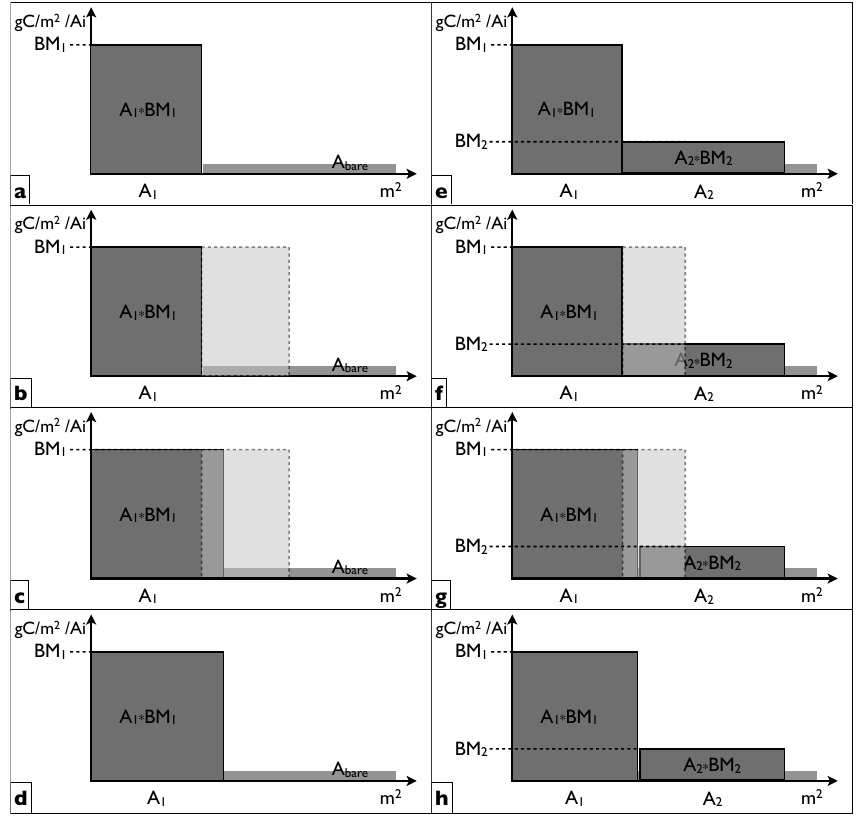
Fig. 2. Illustration of how area is gained via establishment (a–d) and invasion (e–h) . PPS 1 occupies the area A i (a) . The germination fraction would results in a large increase of area covered with seedlings (b) . The actual gain in area by the average population is then determined by the growth rate ( c and d ). If competition happens, the PPS with the higher biomass per occupied area (equivalent to dominance) can invade